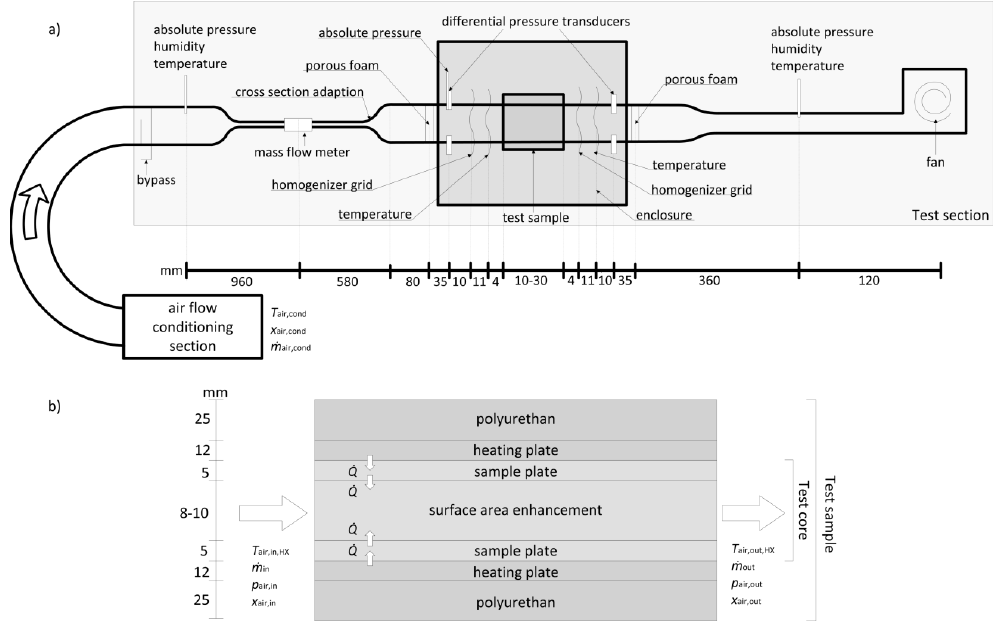
Figure 5. Experimental test set-up scheme: ( a ) forced air convection test section for small scale heat exchanger samples and ( b ) test sample with test core, heating plates and sensor information.